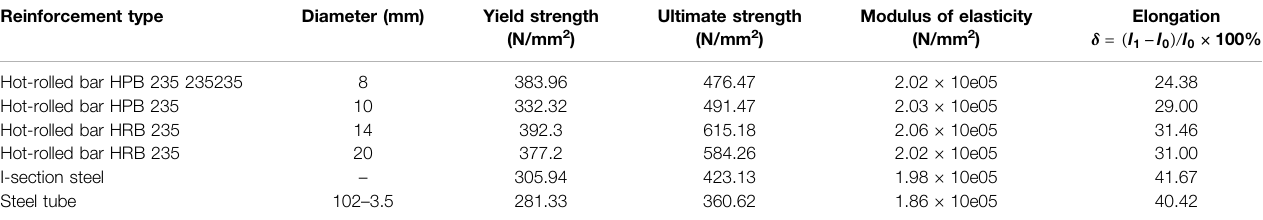
TABLE 3 | Mechanical properties of steel tube, pro fi le steel, and bars. Reinforcement type